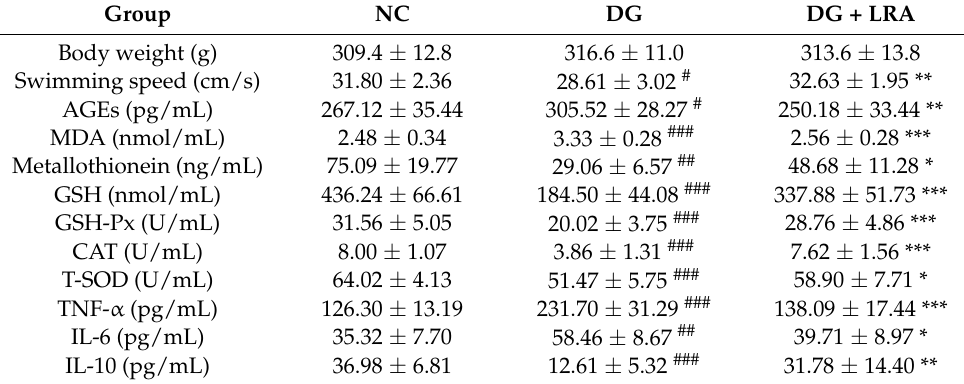
Table 1. Body weight, swimming speed, and serum aging-related biomarkers including AGEs, MDA, metallothionein, GSH, antioxidant enzymes, and inflammatory